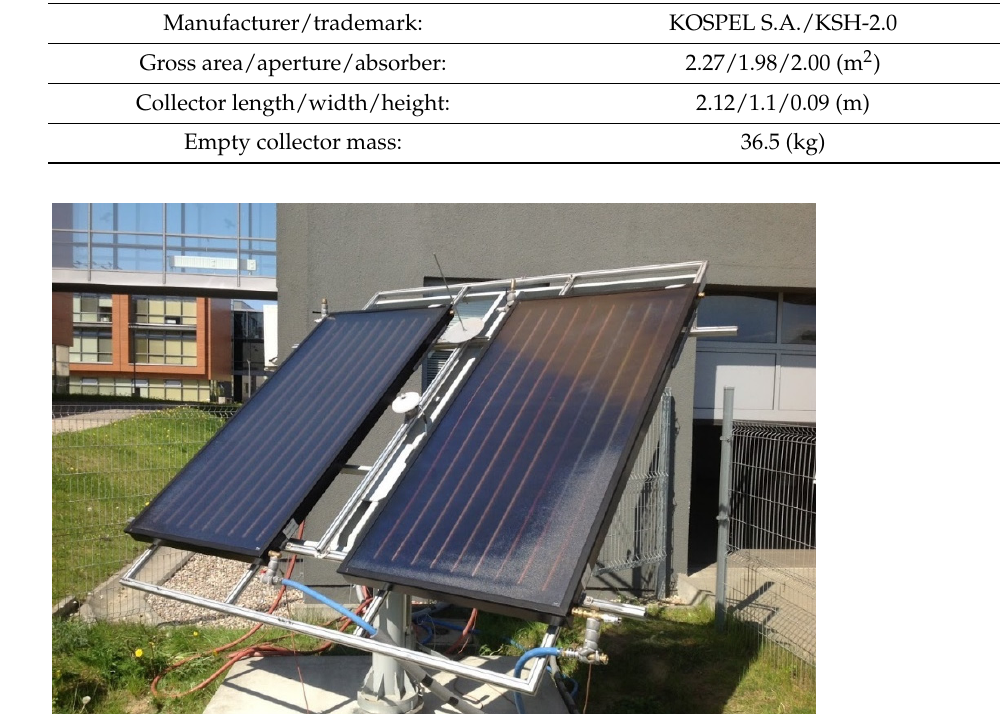
Figure 8. Outdoor platform with solar flat-plate collectors [34].